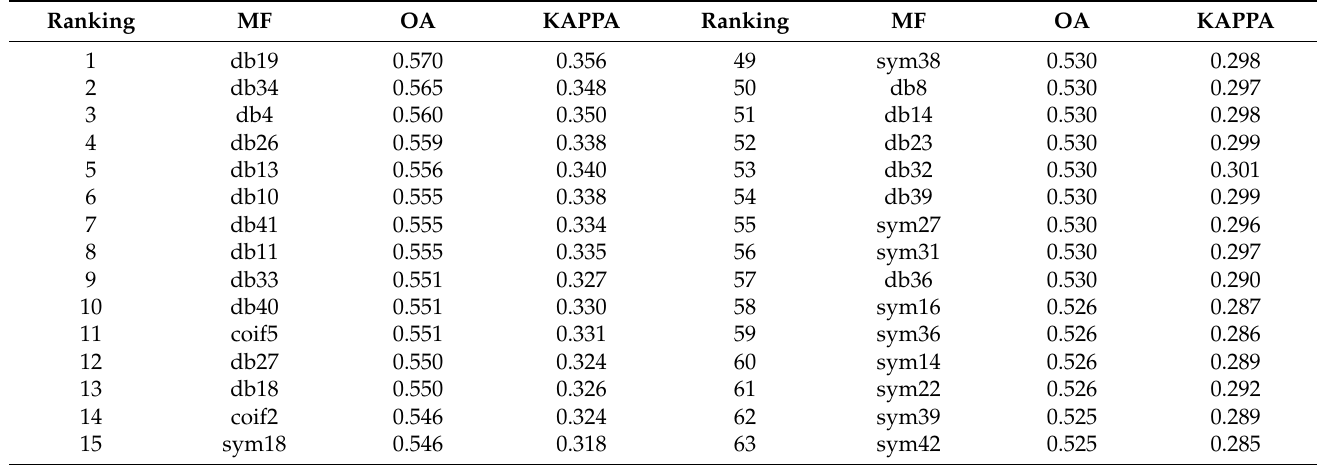
Table 5. Overall accuracy and KAPPA coefficients of different MF (ranked in terms of overall accu- racy).